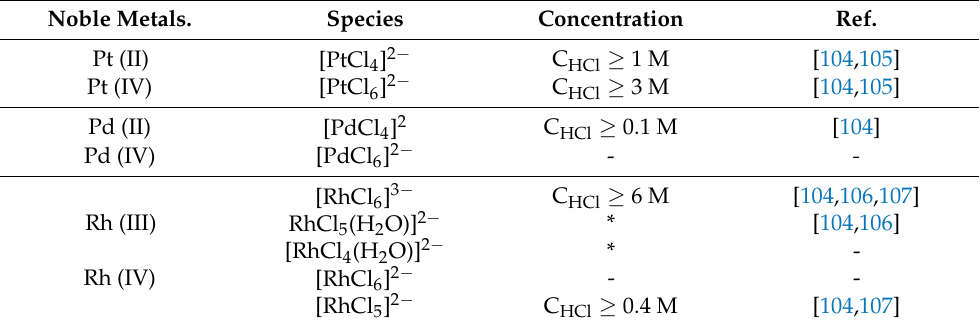
Table 4. PGM species found as chloro-complexes in aqueous chloride media at different concentra- tion values. Noble Metals. Species Concentration